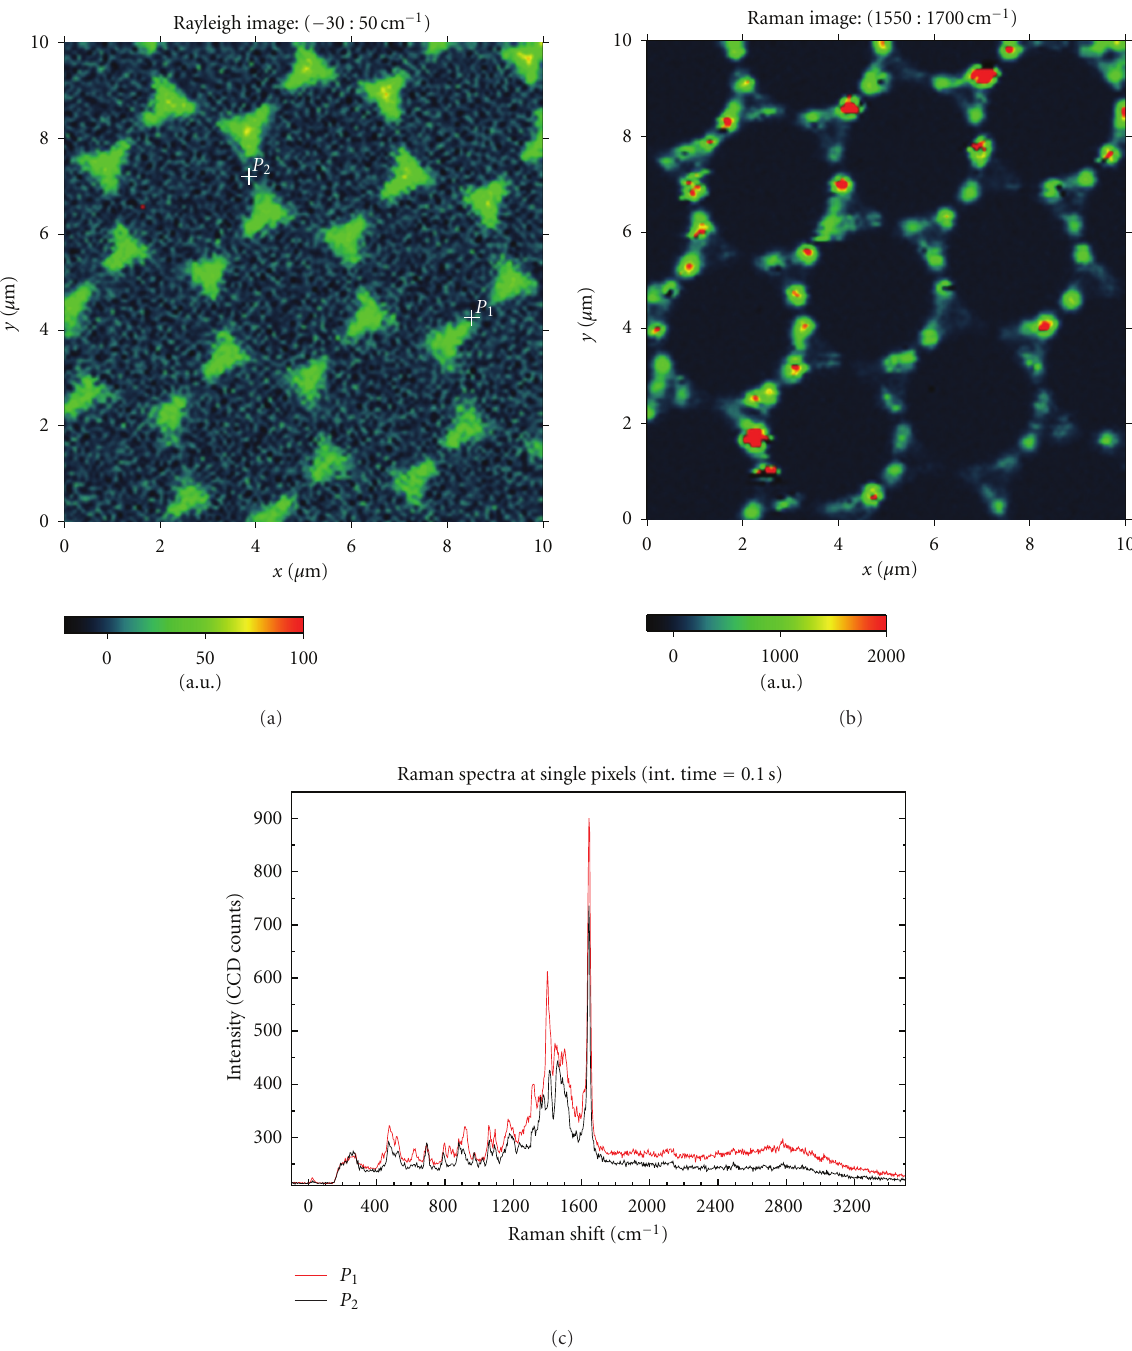
Figure 7: SERS of methylene blue molecules. λ = 532nm. P exc = 9 . 5 μ W. The spectra below were extracted from the pixels marked.